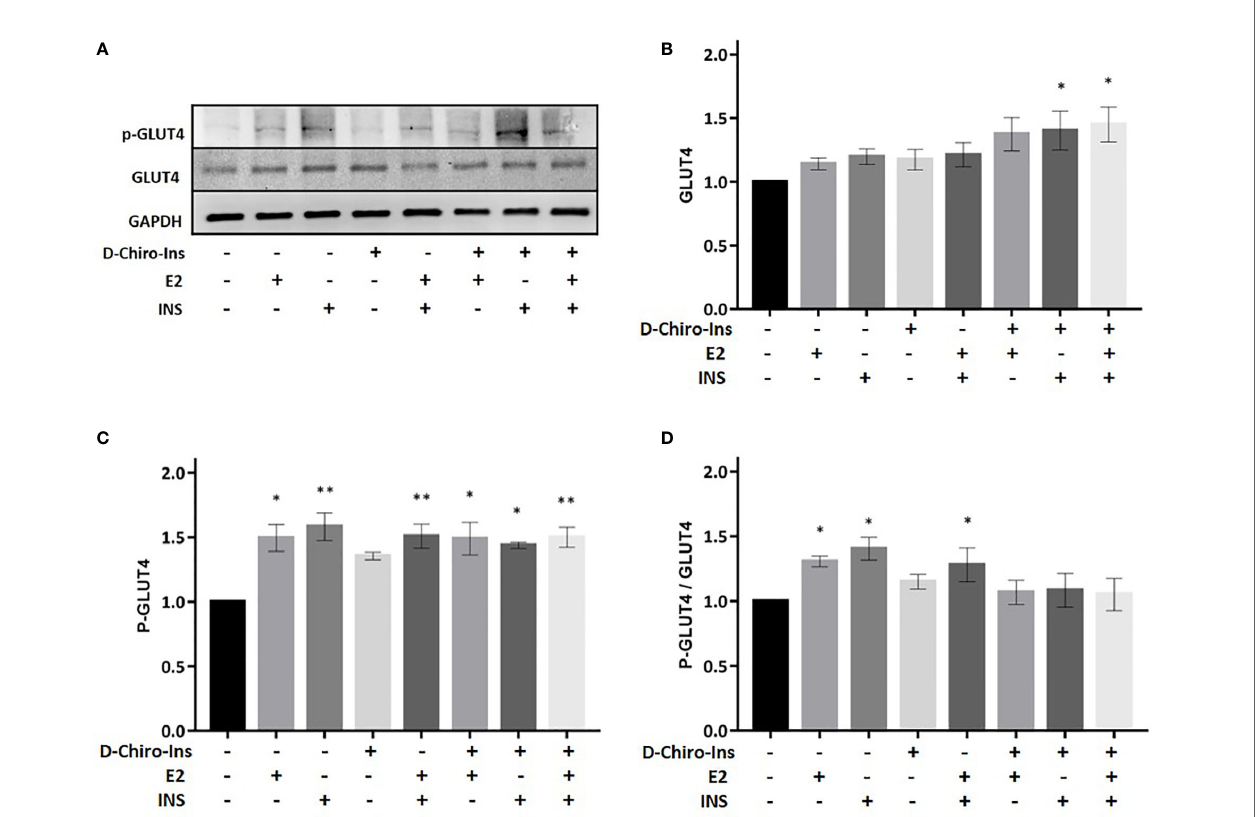
FIGURE 7 | D-Chiro-Ins does not modulate the expression of GLUT4. Mature SGBS adipocytes cells were treated with D-Chiro-Ins 10 − 8 M, E2 10 − 9 M or INS 10 − 7 M, and combinations for 24 h. Cell lysates were immunoblotted with an anti-GLUT4 antibody, anti-p-GLUT4 antibody, and anti-GAPDH antibody. (A) Panels show representative blot of GLUT4, p-GLUT4 S488 and GAPDH. (B – D) Analysis of the relative expression level of GLUT4, p-GLUT4 and the ratio p-GLUT4/GLUT4; expression that was normalized with GAPDH and relative to the control. Values are presented as mean ± SEM of three independent experiments. Results were analyzed statistically by one-way RM ANOVA followed by Dunnett ’ s multiple comparisons test (*p < 0.05, **p < 0.001 versus control). D-Chiro-Ins, D-chiro-Inositol; E2, 17 b -estradiol, INS, insulin; GLUT4, Glucose Transporter 4; p-GLUT4, phospho-GLUT4; GAPDH, glyceraldehyde-3-phosphate